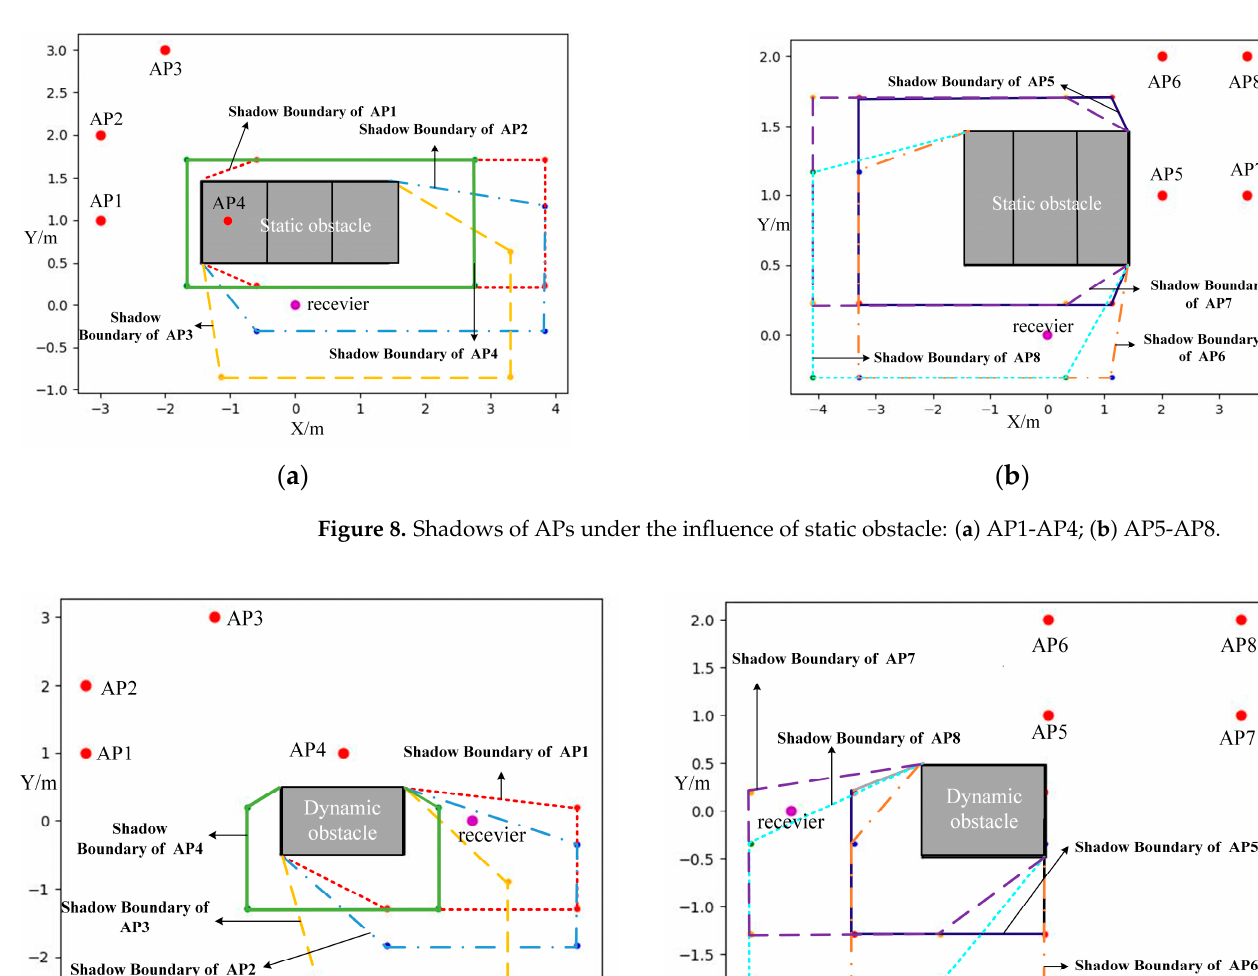
Figure 9. Shadows of APs under the influence of dynamic obstacles: ( a ) AP1-AP4; ( b ) AP5-AP8. 5.2. Verification of the Model when Obstacles Are at the Critical Position The position of the obstacle in this simulation is the same as in Model Analysis